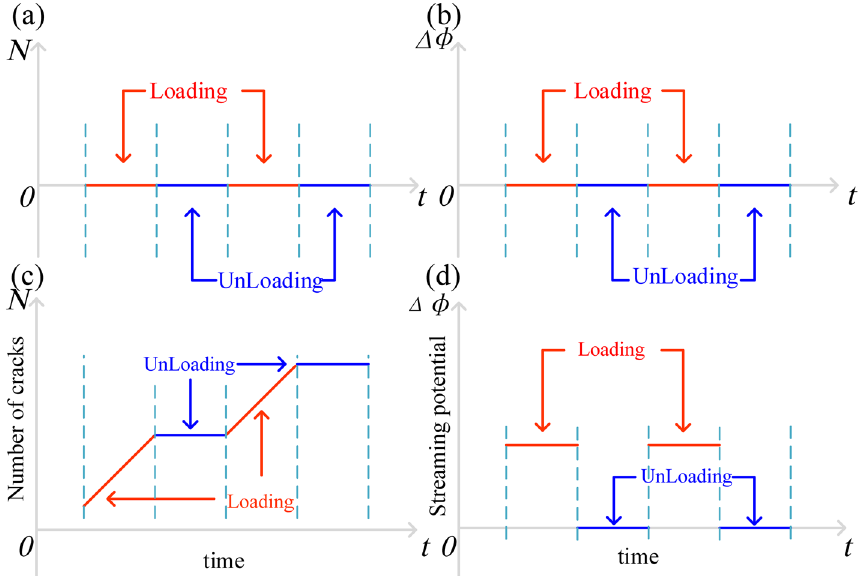
Figure 9. Rupture number and potential difference in steady and damage states during the loading and unloading process; ( a ) and ( b ) are changes in fracture number and flow potential in the elastic stage, respectively; ( c ) and ( d ) are changes in fracture number and flow potential in the dilatant stage,